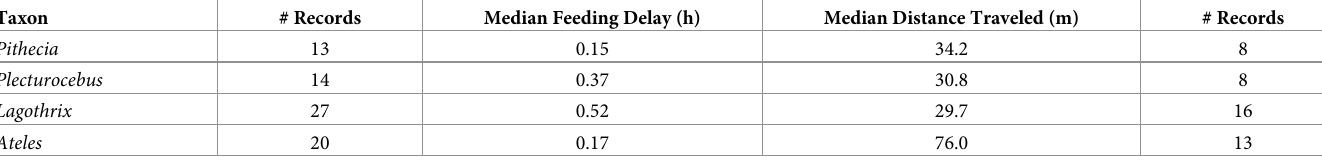
Table 5. Feeding delays and distance